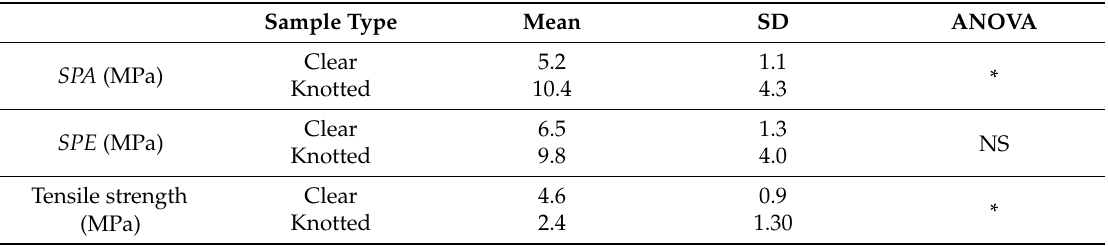
Table 4. Average values of SPA , SPE and TPE of samples with and without